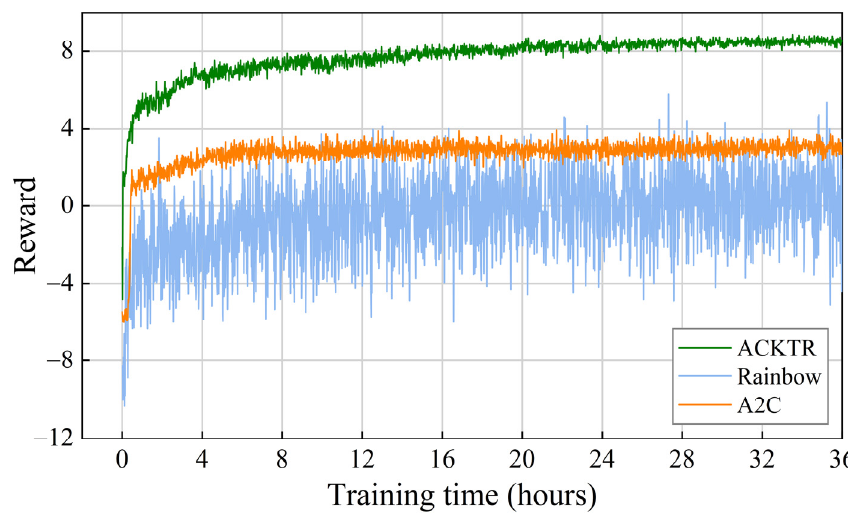
Figure 12. Training speed of ACKTR, Rainbow, and A2C on the same training set. Table 6. Training data of different algorithms.